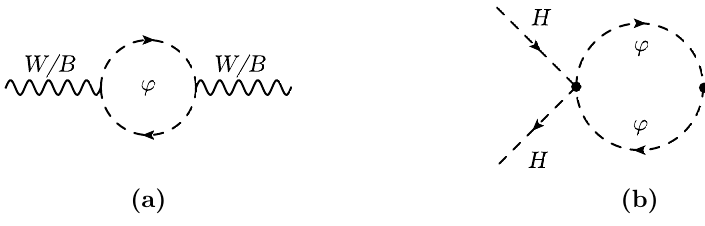
Figure 1. Feynman diagrams corresponding to the contributions from the scalar (cid:12)eld ’ to the one-loop standard model beta function. Figure (a) shows the contribution to the gauge boson (cid:12)eld counterterms which must be subtracted when gauge bosons appear in external states in Green’s functions. Figure (b) shows the ’ loop contributing to the one-loop Higgs quartic coupling beta function.